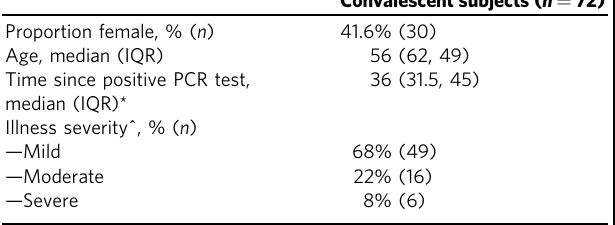
Table 1 Characteristics of COVID-19 convalescent